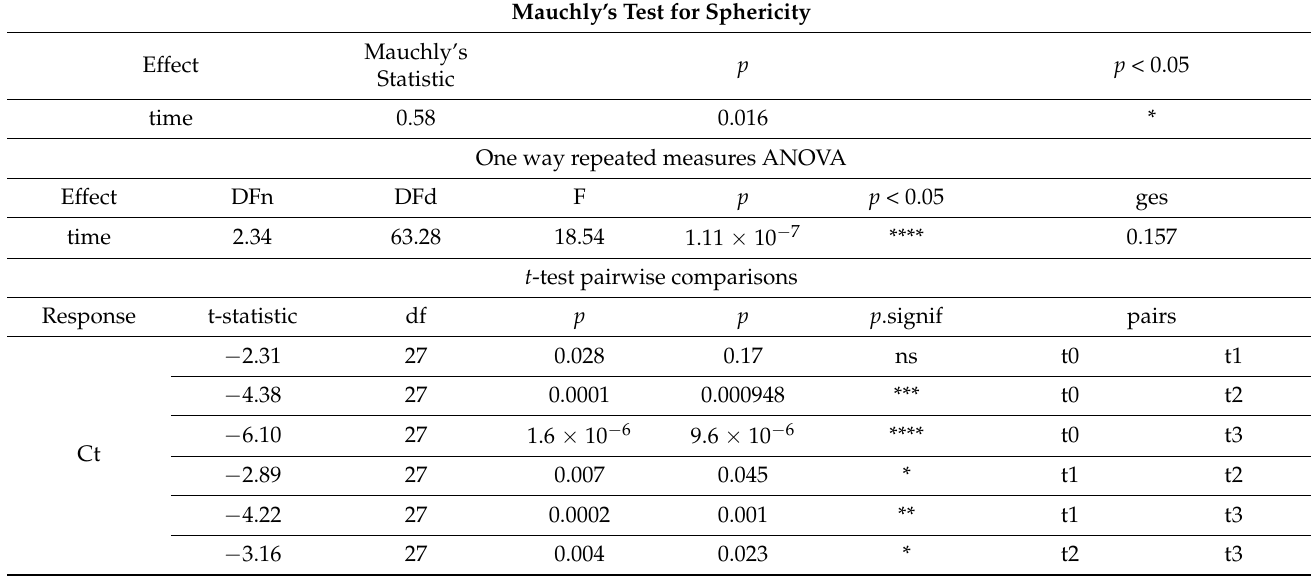
Table 3. The statistical results of the parametric tests (ANOVA, T-test) for Herpes Viruses. The asterisks denote significance codes, namely ‘****’ stands for p -value < 0.0001, ‘***’ stands for p -value < 0.001, ‘**’ stands for p -value < 0.01, ‘*’ stands for p -value < 0.05, and ‘ns’ stands for non- significant, after Bonferroni